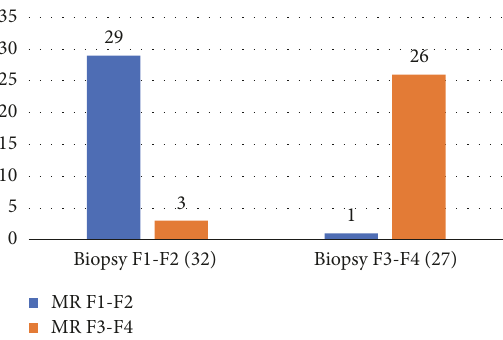
Figure 1: MR triple test correlation with biopsy results. Figure depicts the number of patients misdiagnosed by Triple test in two categories (significant and insignificant